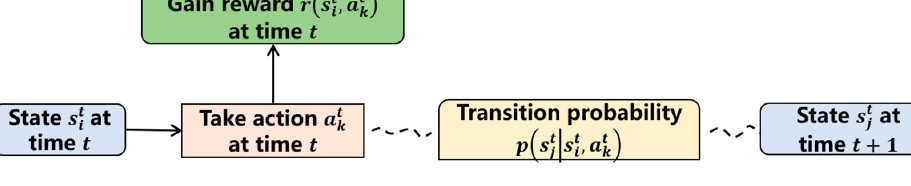
Figure 1. The MDP model.